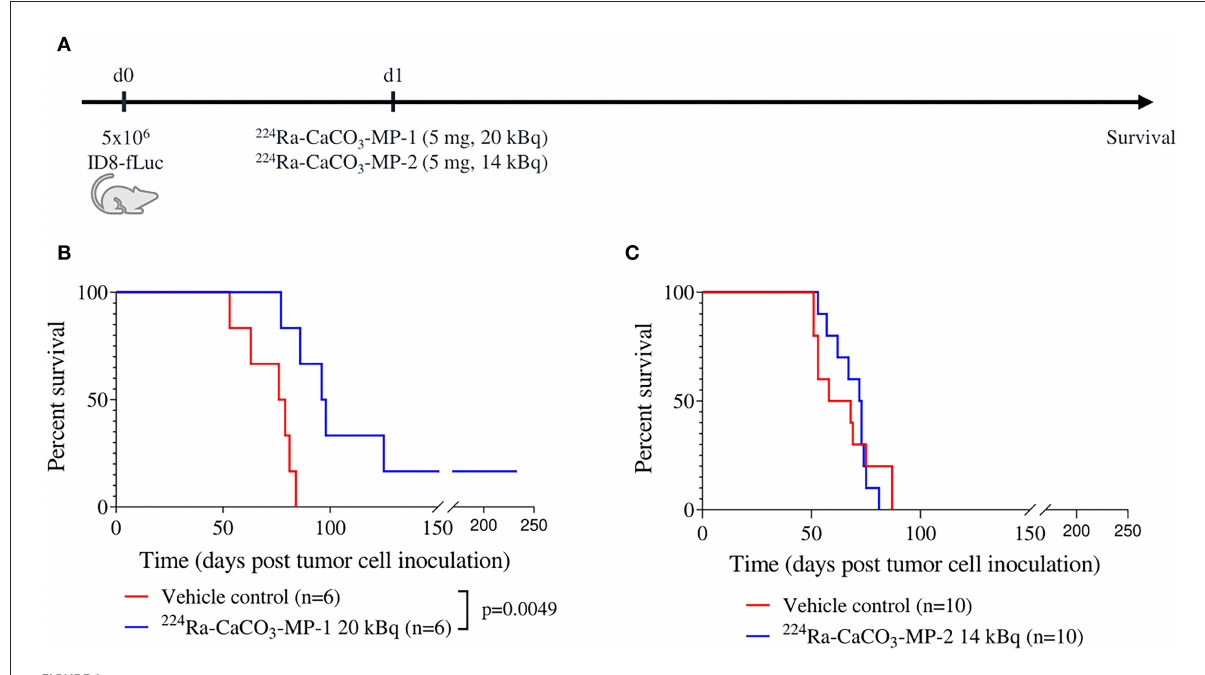
FIGURE1 Experimental set-up (A) with corresponding Kaplan-Meier curves (B,C) for survival of mice injected IP with vehicle control and 224 Ra-CaCO